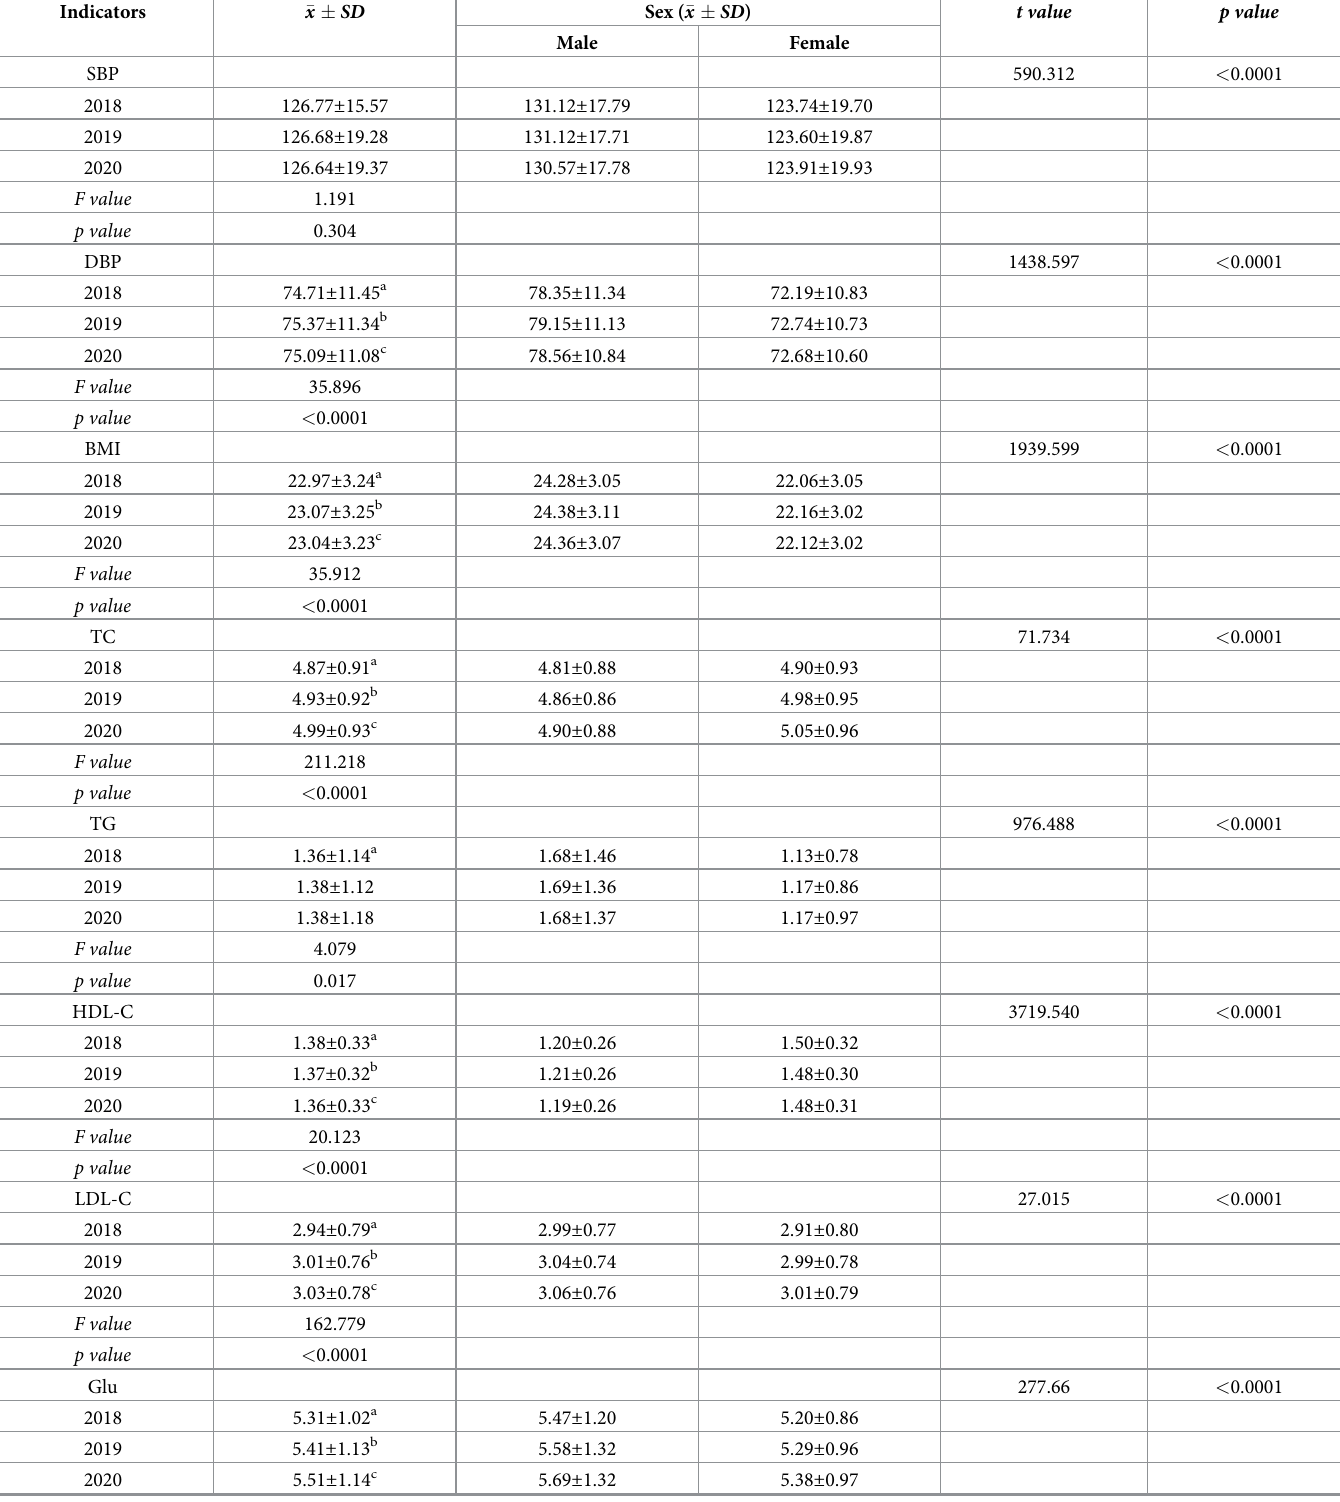
Table 3. Characteristics of cardiovascular health indicators of participants with different